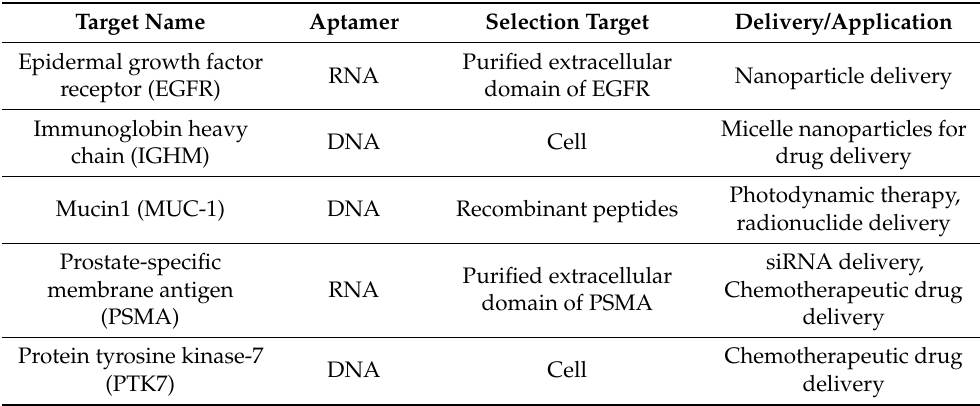
Table 3. Aptamers for the targeted drug delivery.